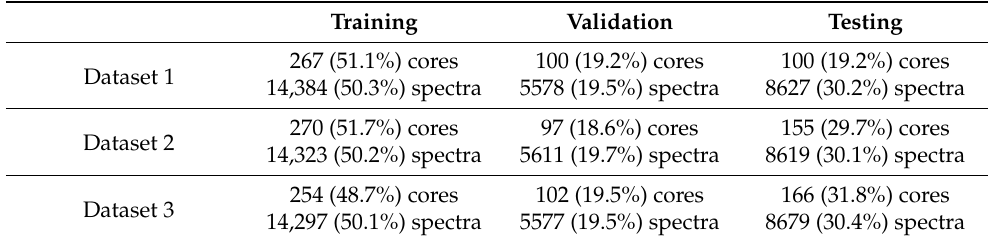
Table 3. Dataset sizes after random split (percentage of total in